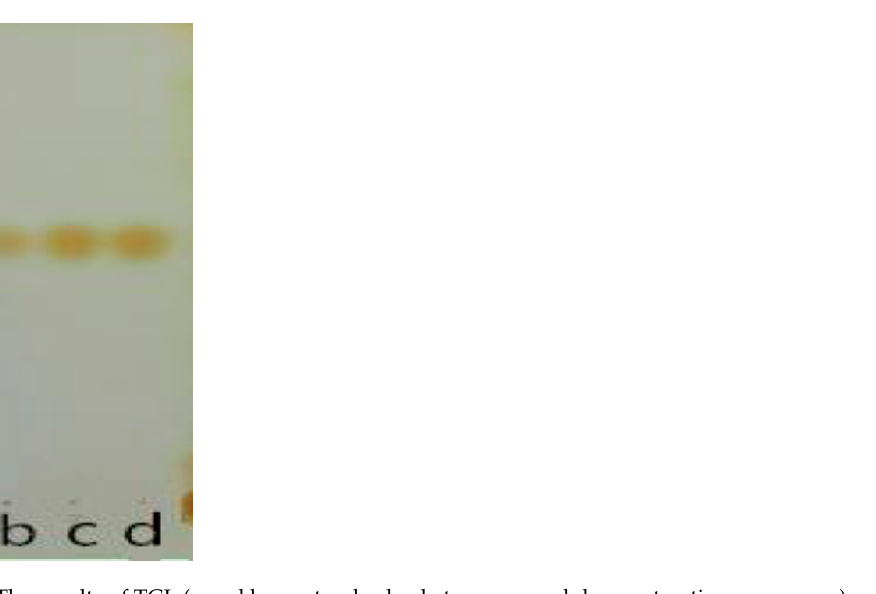
Figure 2. The results of TCL (a and b are standard substances; c and d are extractive monomers)